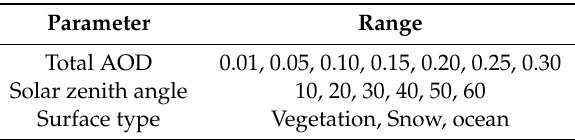
Table 4. Range of parameters used for